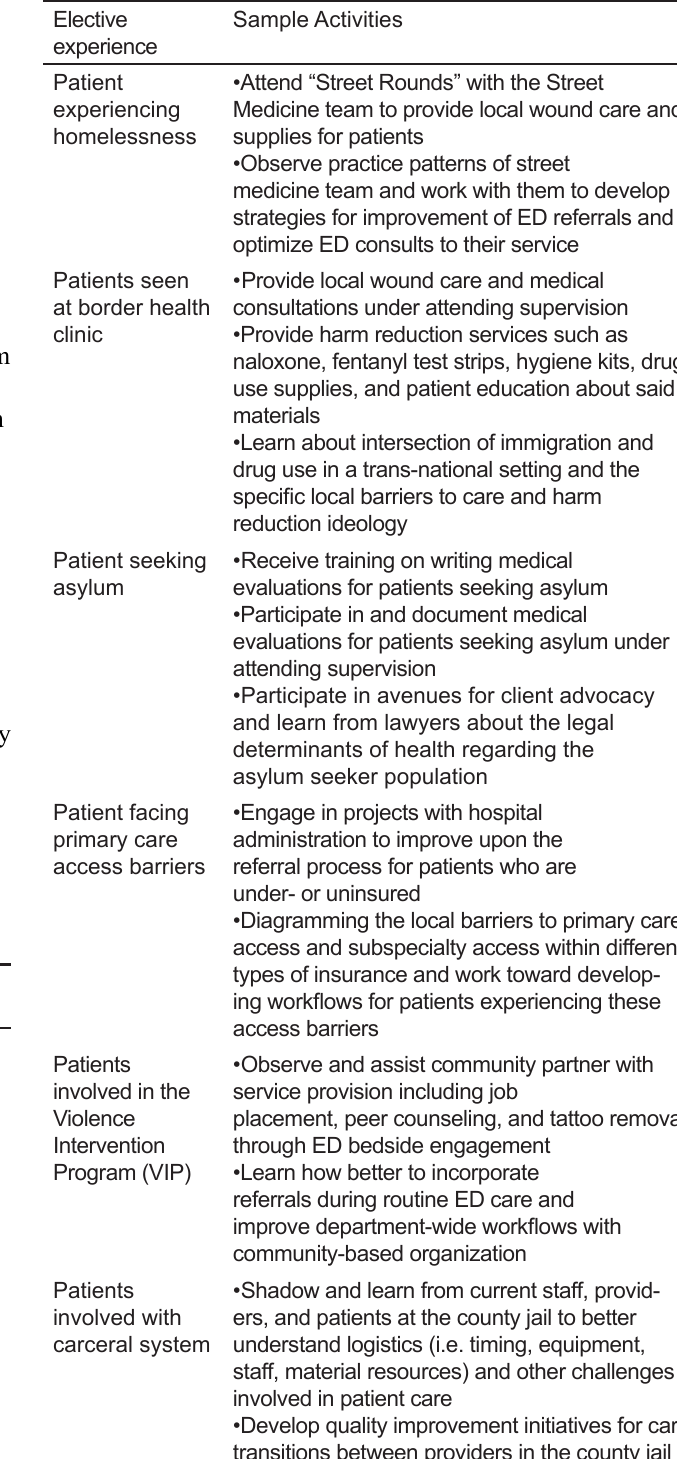
Table 1 Continued. Description of Social Medicine